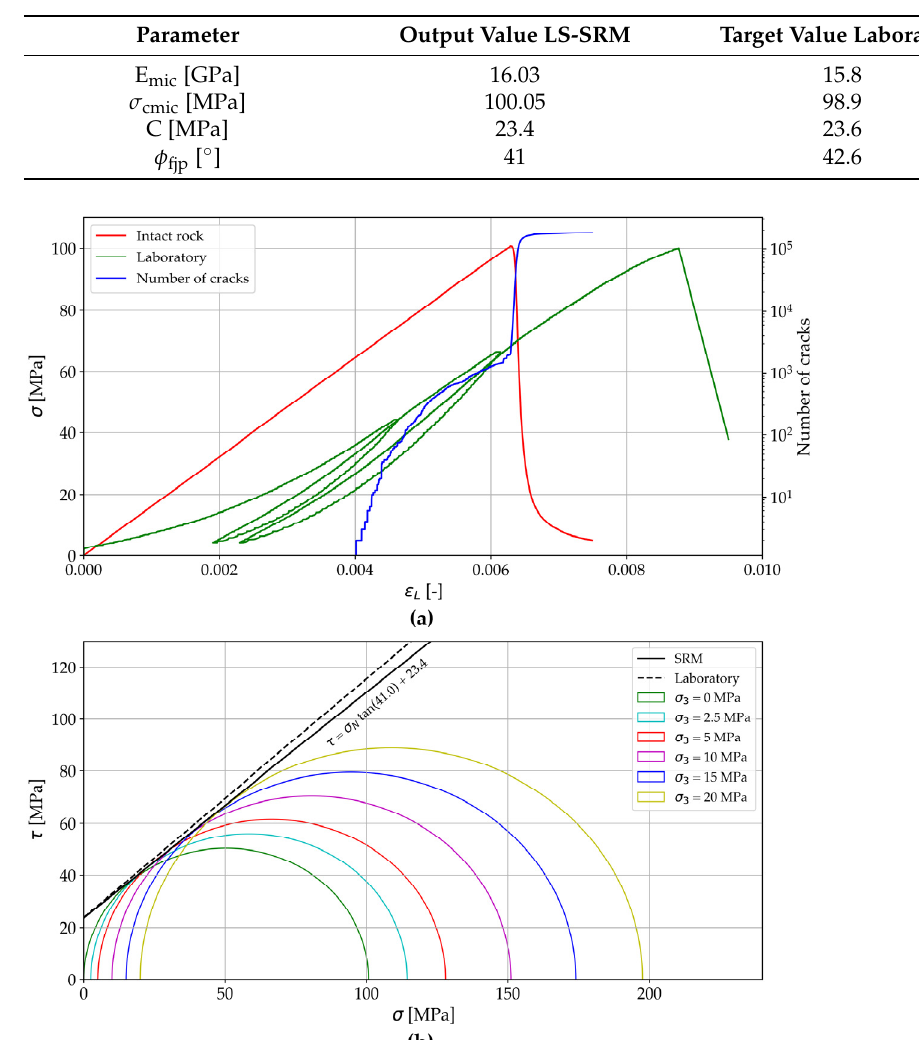
Table 5. Results of the intact rock calibration.